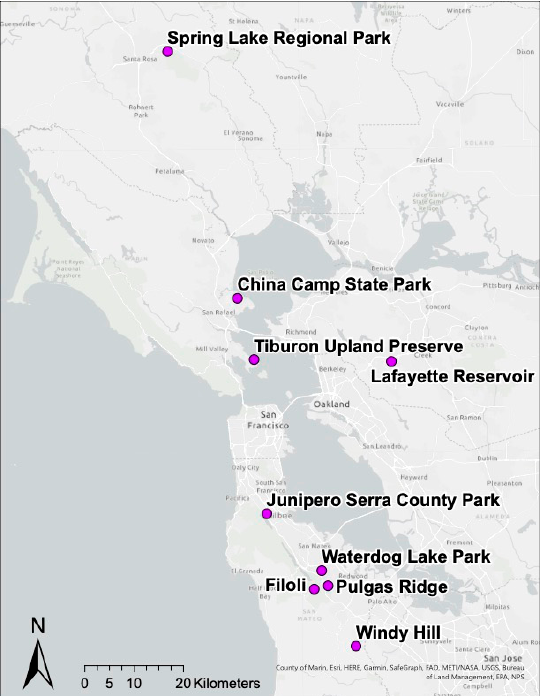
Figure 1. Map of nine sites across Northern California where field plots were established for Lyme disease surveillance and bird, mammalian, tick, and reptilian communities were sampled. disease surveillance and bird, mammalian, tick, and reptilian communities were